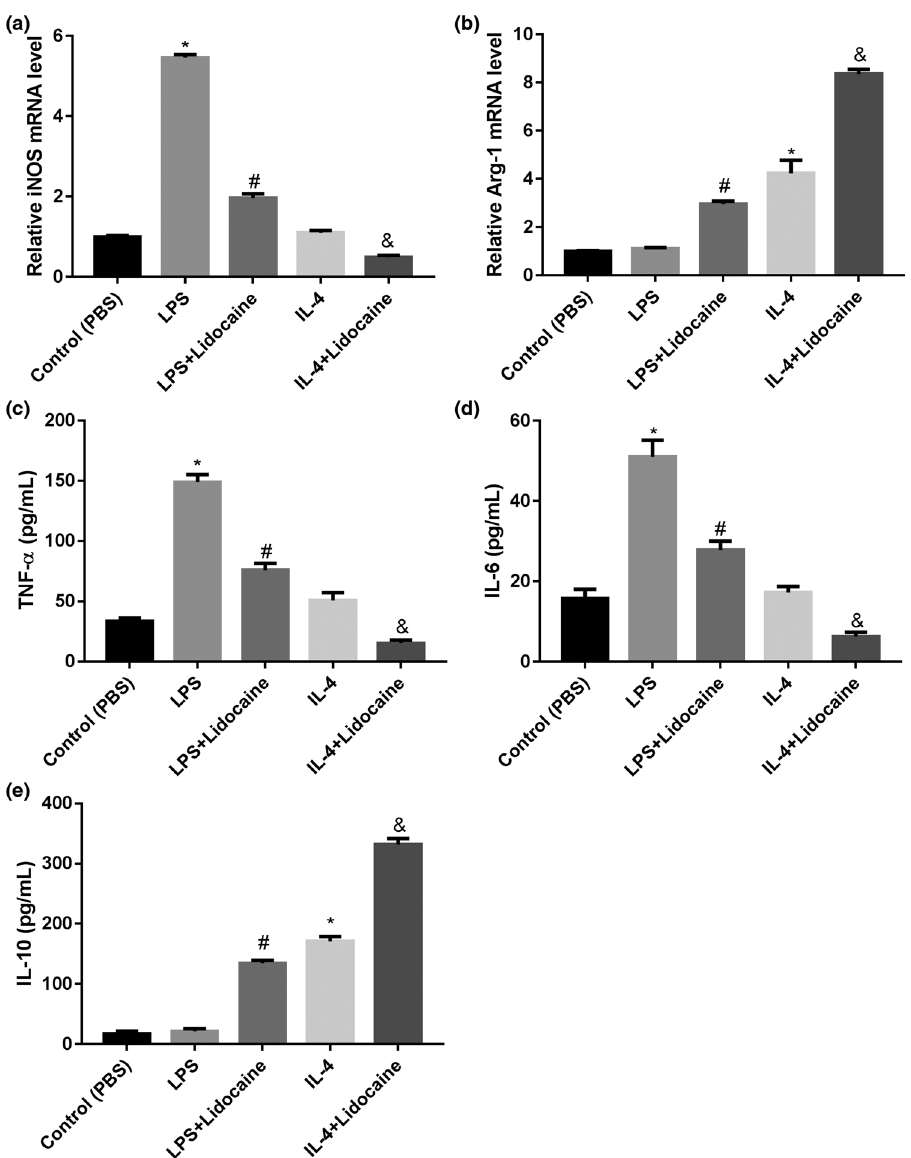
Figure 5: Lidocaine inhibits M1 polarization but promoted M2 polarization in HAPI microglia. The expression levels of ( a ) M1 marker iNOS and ( b ) M2 marker Arg - 1 in LPS - or IL - 4 - treated HAPI microglia were measured using qRT - PCR. ELISA was used to detect ( c ) TNF - α , ( d ) IL - 6, and ( e ) IL - 10 levels in the culture supernatant of LPS - or IL - 4 - treated HAPI microglia. Data are expressed as mean ± SD and were analyzed using one - way ANOVA with Tukey ’ s post hoc test. * p < 0.05 versus Control group; # p < 0.05 versus LPS group; and & p < 0.05 versus IL - 4 group, three independent